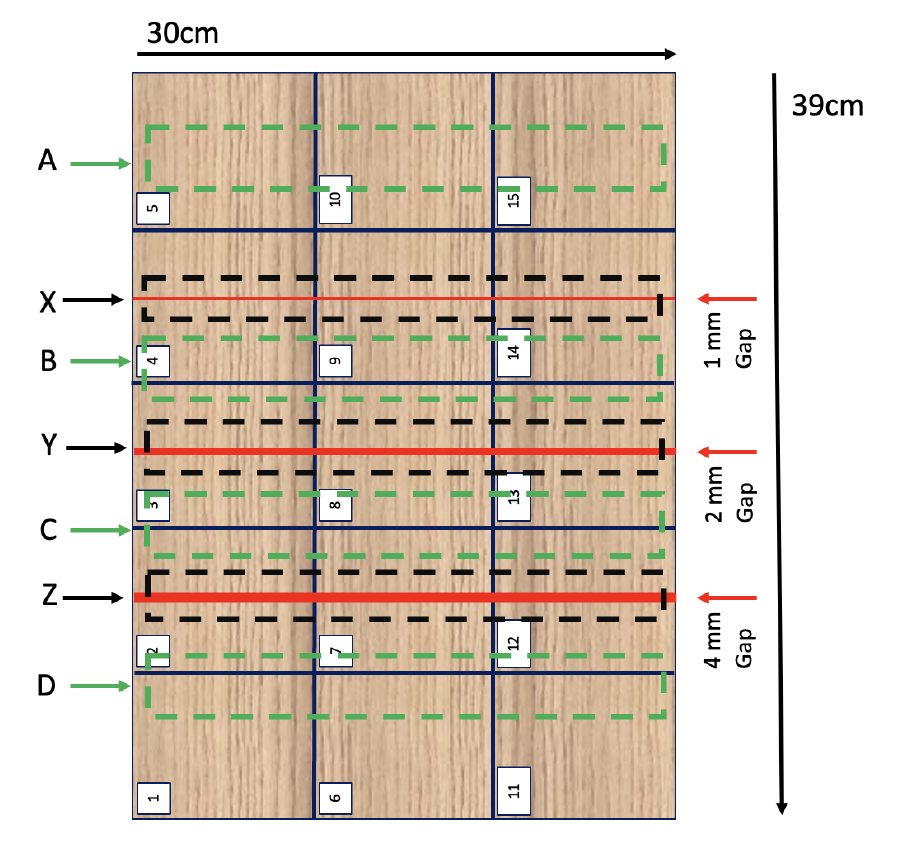
Figure 7. Data collection of defect and healthy area of samples No.5, areas labelled as A, B, C and D represent for healthy areas, where areas X, Y, and Z represent for areas containing the air voids defect of different sizes.